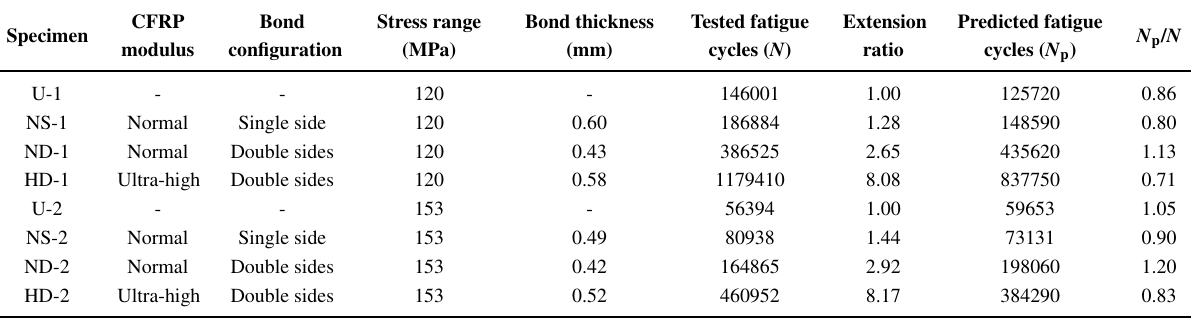
Table 1. Experimental program and results.